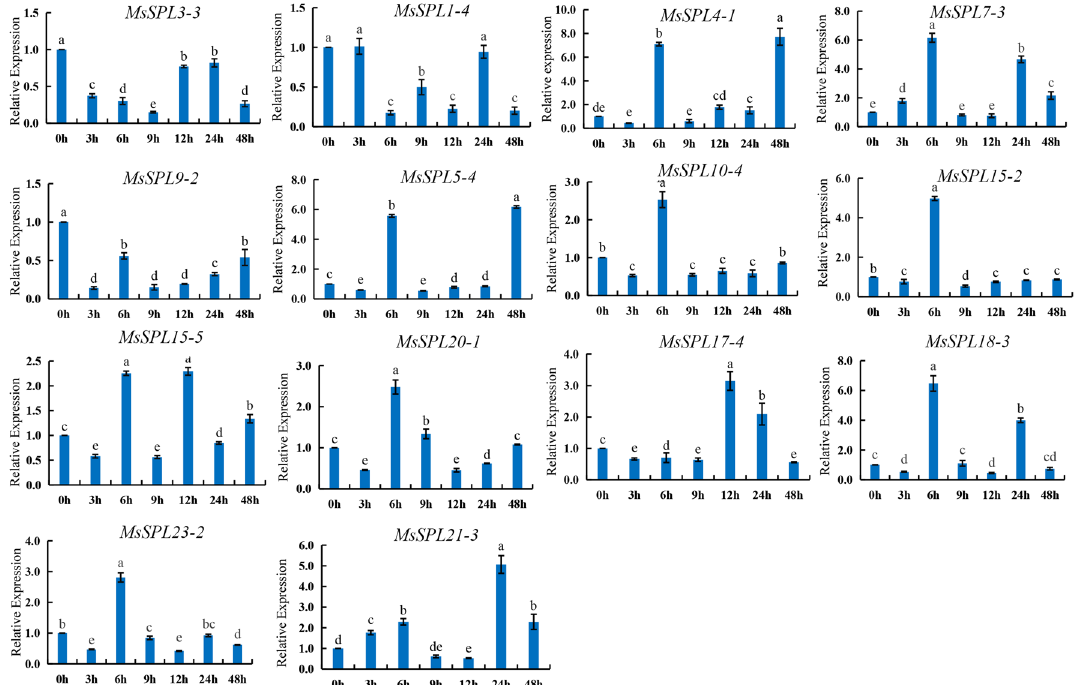
Figure 8. Gene expression of 14 MsSPL genes under Me JA treatment at 0 h, 3 h, 6 h, 9 h, 12 h, 24 h and 48 h was analyzed using qRT-PCR. Error bars represent standard errors of three biological replicates. The differernt lowercase letters indicate significant differences at the P < 0.05